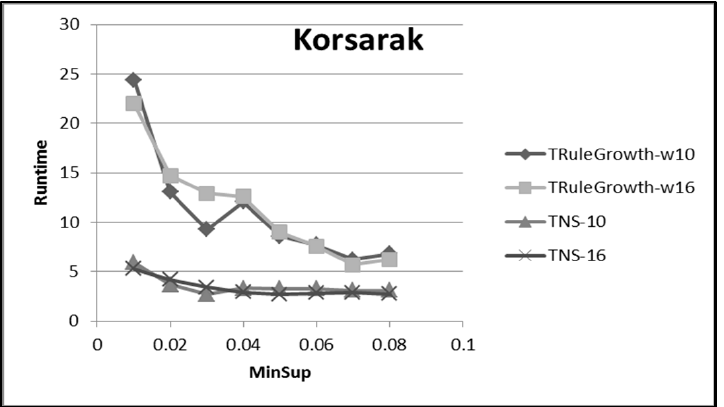
Figure 19. Comparison of the runtime of the TNS with the TRuleGrowth for (Korsarak) dataset.